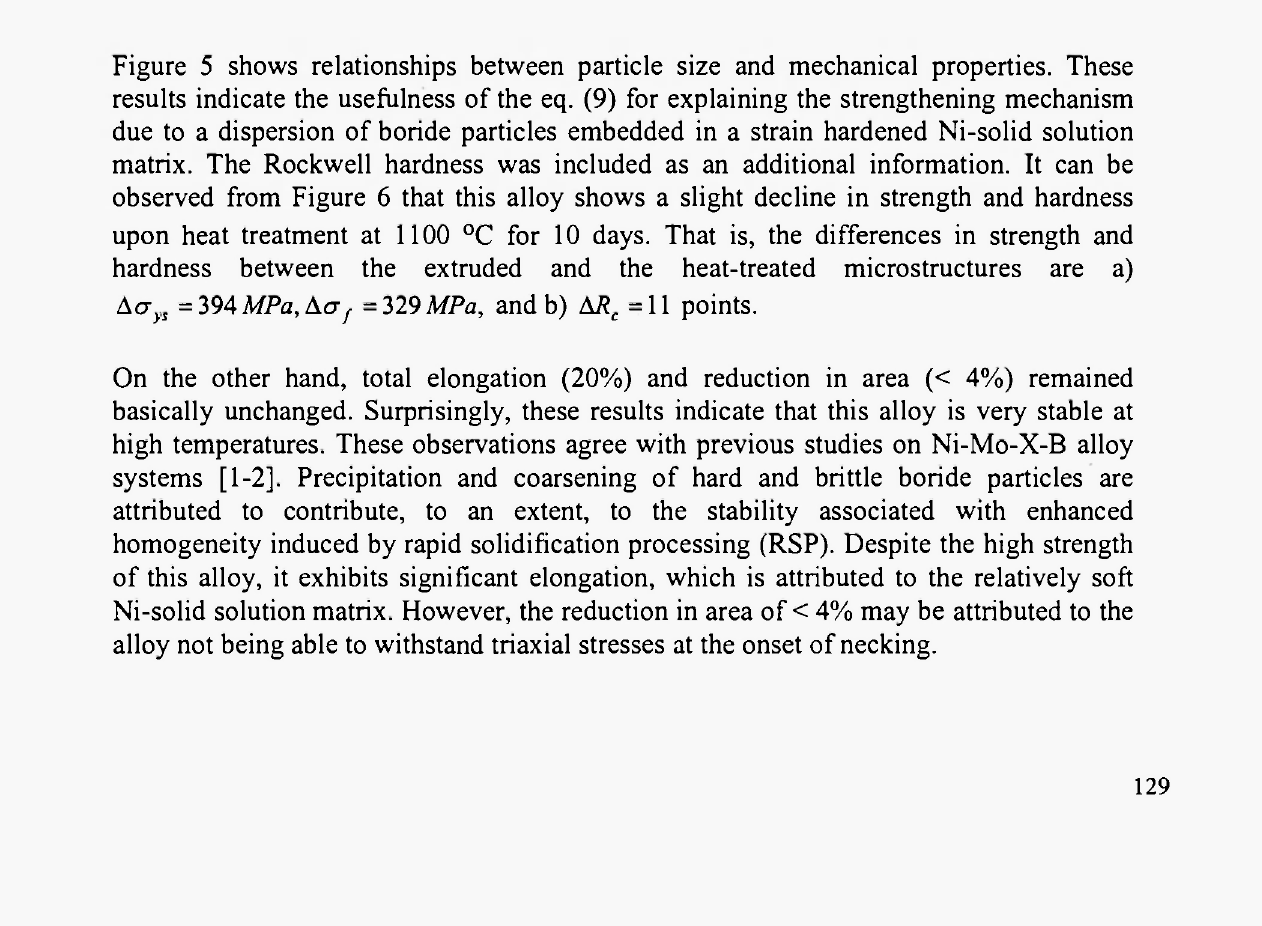
Figure 4. Fracture surfaces of tensile specimens showing small dimple